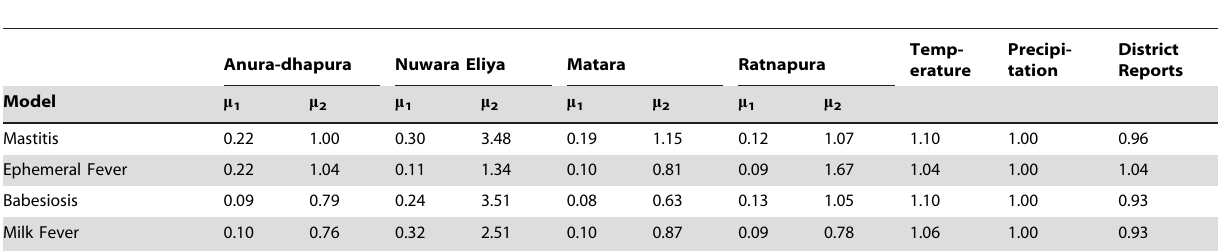
Table 4. Model results for four commonly reported cattle